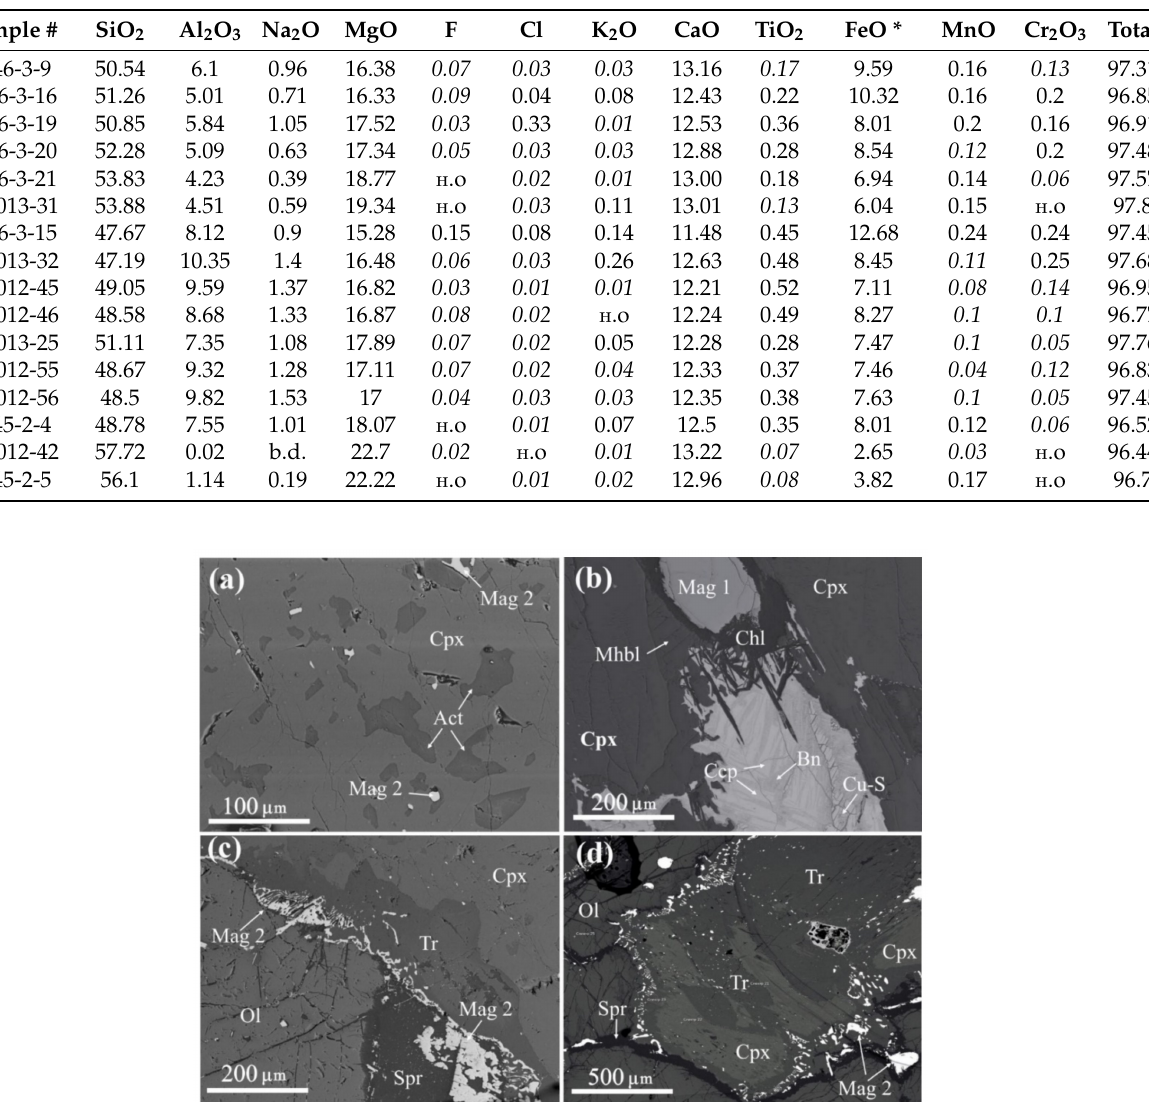
Figure 5. Amphibole in the samples of clinopyroxenite I ( a , c ), II ( b ), and III ( d ). ( a )